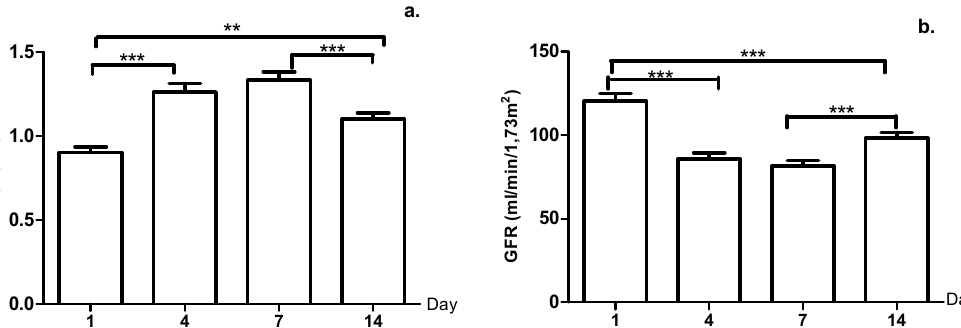
Figure 3. ( a ) Creatinine (Cr) levels; ( b ) Glomerular filtration rate (GFR) during the micro-cycle, **: p -value < 0.01, ***: p -value < 0.001.